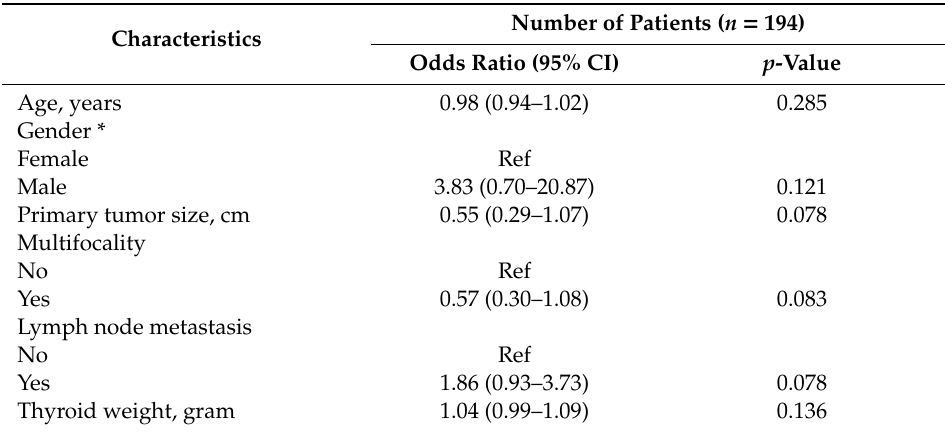
Table 4. Potential risk factors associated with the development of temporary hypoparathyroidism as determined by backward selection ( p <